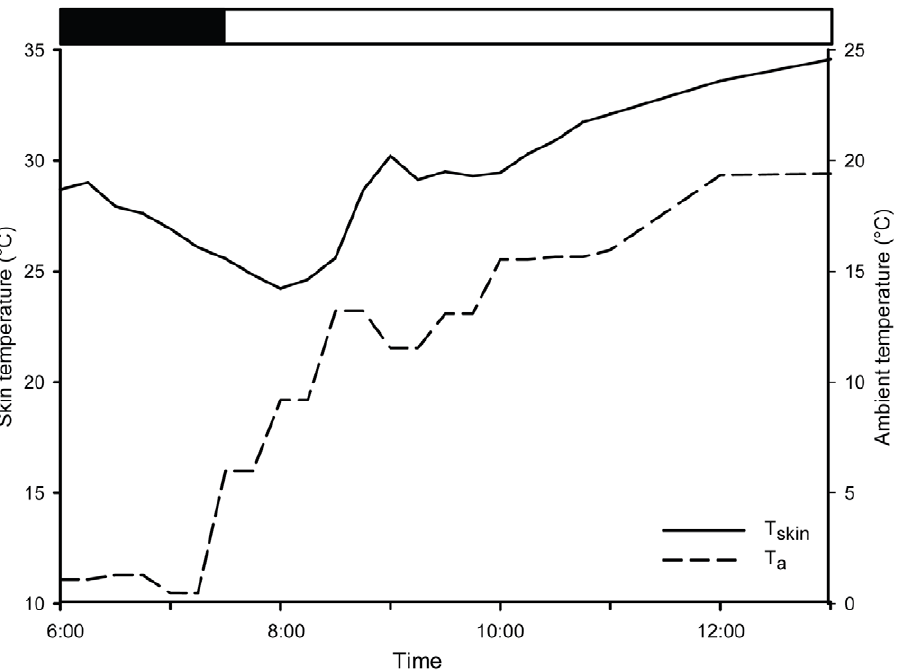
Figure 1. Skin temperature profile of a sub adult male G.moholi in winter including a torpor bout. Skin temperature (T skin ) started dropping in the morning at 6am. The male was torpid for about four hours until 10am. Black line shows T skin , dashed line shows ambient temperature (T a ). Black bar indicates the dark phase, white bar indicates the daytime.